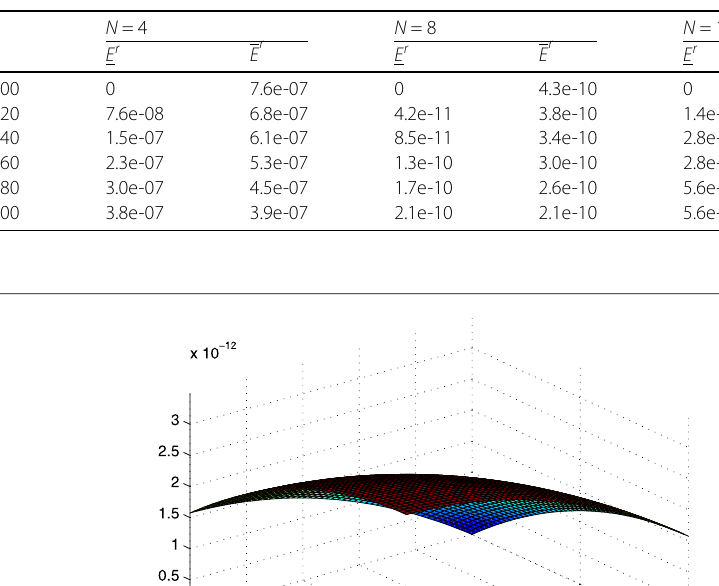
Table 3 Numerical errors on the level sets with N = M in ( x , y ) = (0.5.0.5) for Example 5.2